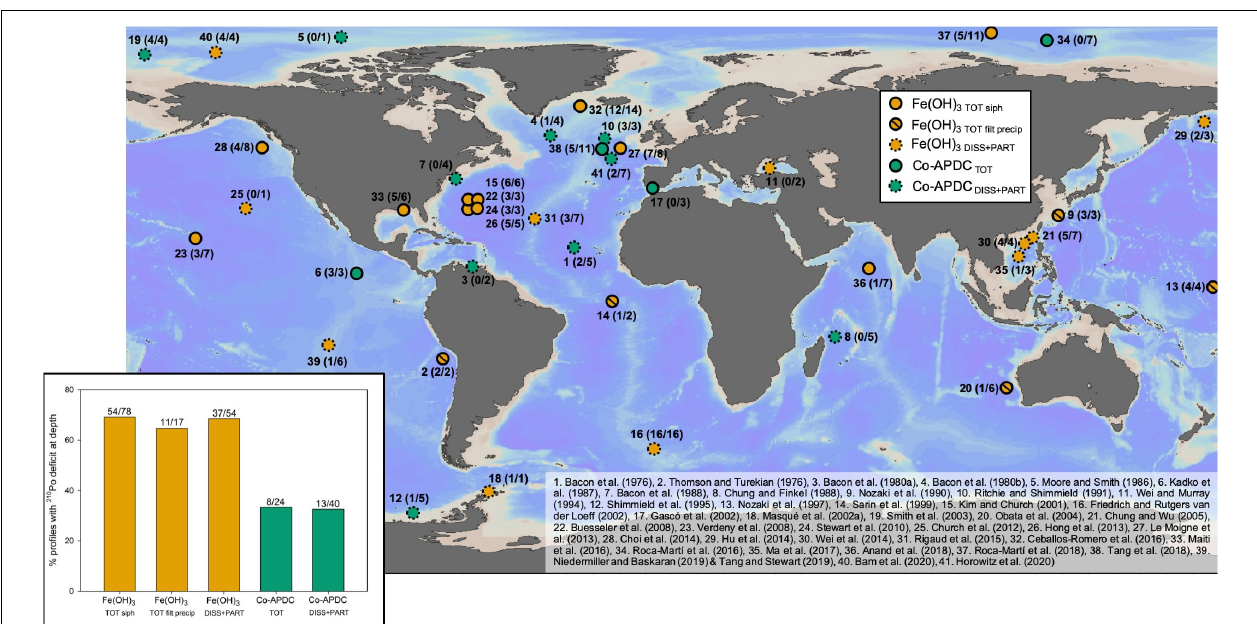
FIGURE 1 | Compilation of studies reporting depth profiles ( ≥ 300 m) of total 210 Pb and 210 Po activities. Legend shows the precipitation method used in each study: Fe(OH) 3 TOT siph , Fe(OH) 3 TOT filt precip , Fe(OH) 3 DISS + PART , Co-APDC TOT , Co-APDC DISS + PART (see section “Compilation of 210 Pb and 210 Po Studies” for definitions). Many of these studies represent a transect of stations but for clarity the dots represent the location of one of the stations sampled for 210 Pb and 210 Po per study. The number next to each dot corresponds to the study reference and the numbers in parentheses refer to the number of profiles where deficits of 210 Po (total 210 Po/ 210 Pb activity ratios < 0.8) at depth were found, as shown by at least two data points from ≥ 300 m, with respect to the total profiles analyzed per study. The inset plot shows the percentage of profiles with deficits of 210 Po at depth with respect to the total profiles analyzed per method considering all studies compiled. To avoid duplication, data from the D341 cruise presented in Le Moigne et al. (2013) were excluded from the dataset presented in Ceballos-Romero et al. (2016); data from Roca-Martí et al. (2018) were obtained from a combination of unfiltered and prefiltered samples [Fe(OH) 3 TOT siph and Fe(OH) 3 DISS + PART ].